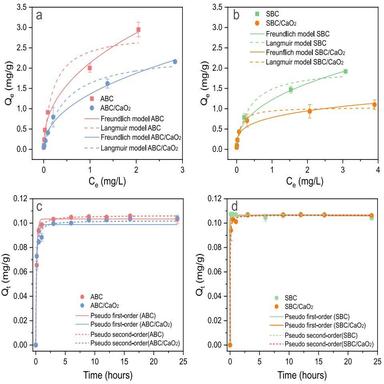
Adsorption isotherm curves for tebuconazole with (a) ABC and ABC/CaO2, and (b) SBC and SBC/CaO2. Adsorption kinetics curves for tebuconazole involving (c) ABC and ABC/CaO2, and (d) SBC and SBC/CaO2.